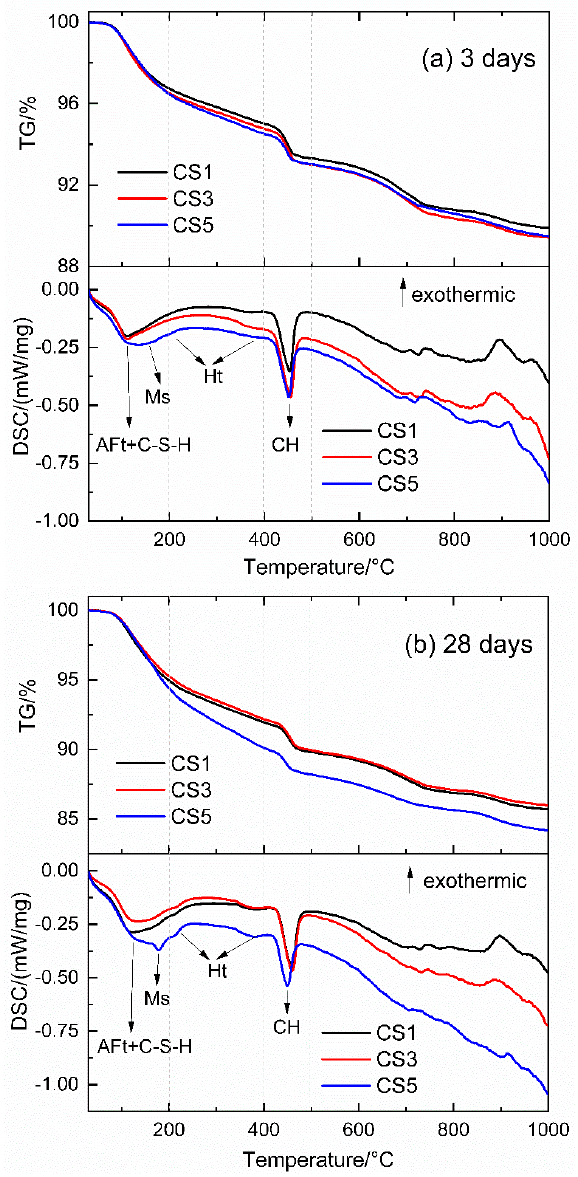
Figure 11. TG-DSC curves of slag pastes at ( a ) 3 days and ( b ) 28 days.